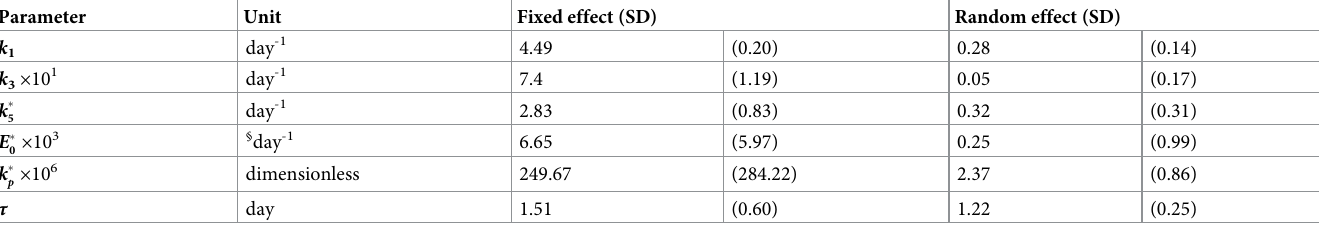
Table 2. Estimated population parameters of the model fit to the sputum viral load dataset [38] (Fig 2).